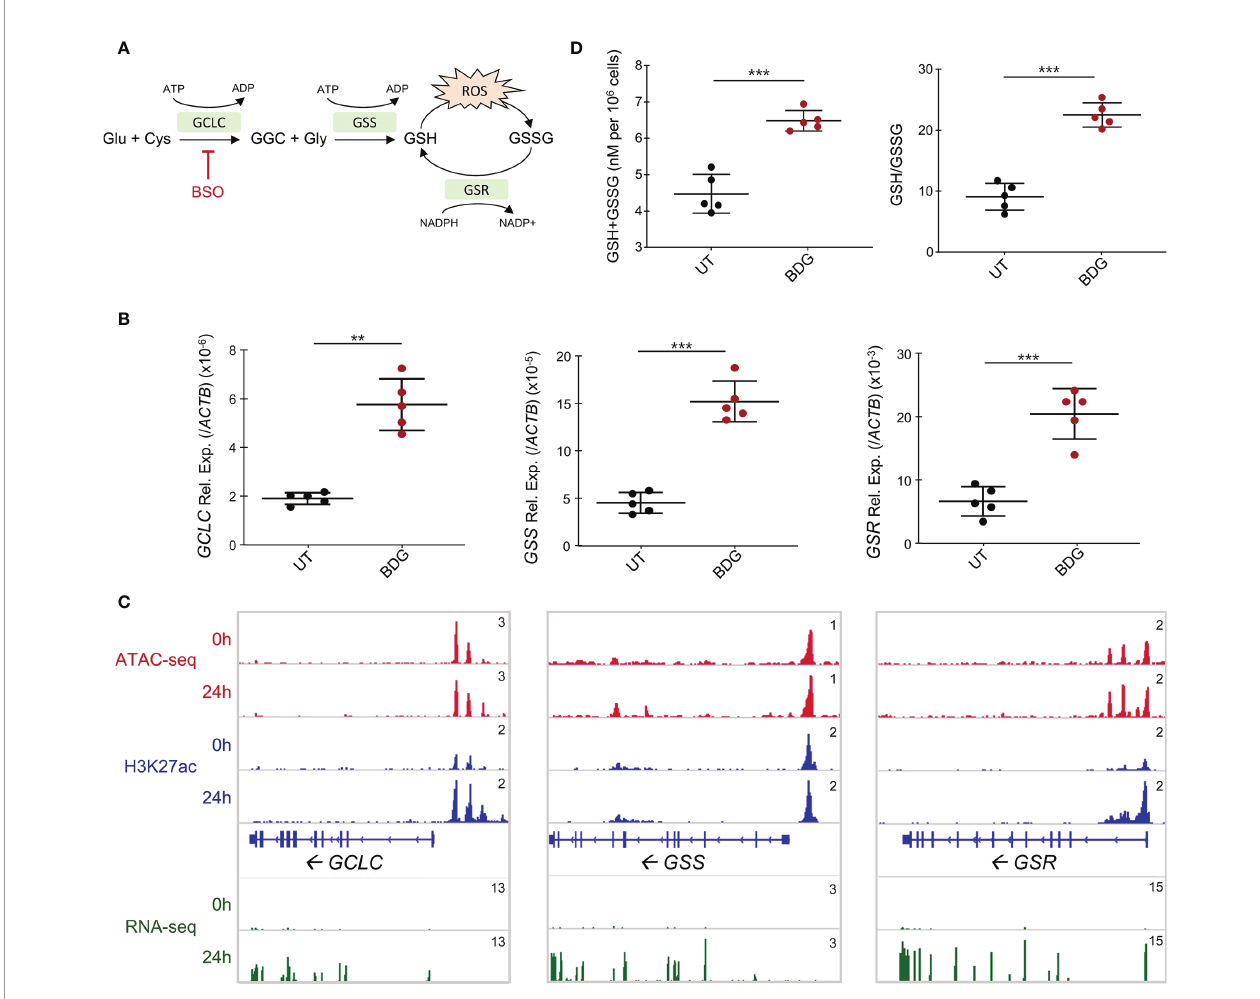
FIGURE 4 | Glutathione synthesis and metabolism are induced by BDG stimulation. (A) Schema of glutathione metabolic pathway with genes that are signi fi cantly upregulated from the RNA-seq in green. (B) Expression of GCLC , GSS , and GSR were evaluated with RT-qPCR. Data are presented as median ± standard deviation of n = 5 biologically independent experiments. (C) ATAC-seq, ChIP-seq, and RNA-seq read density pro fi les at the GCLC, GSS , and GSR loci. (D) Monocytes were stimulated with BDG for 24 hours and assessed for total intracellular glutathione levels and GSH/GSSG using calorimetry. Data are presented as median ± standard deviation of n = 5 biologically independent experiments. P -values were calculated using paired student ’ s t -test. **P < 0.01; *** P <